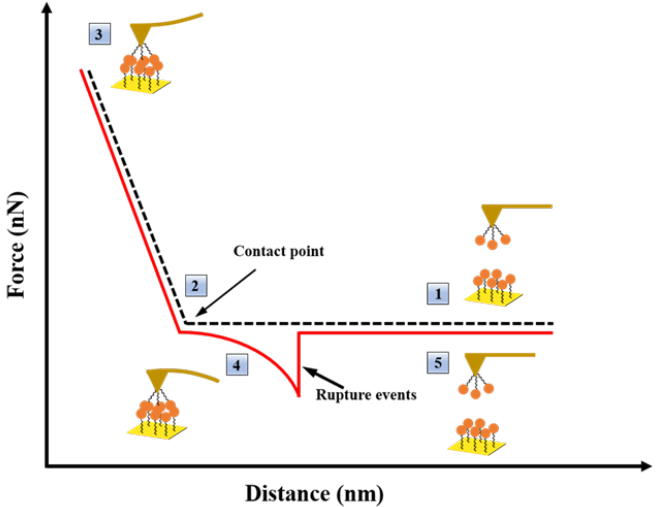
Figure 1. AFM force–distance curve example. The approaching stage is depicted by a dashed line, whereas the withdrawing stage is depicted by a solid line.